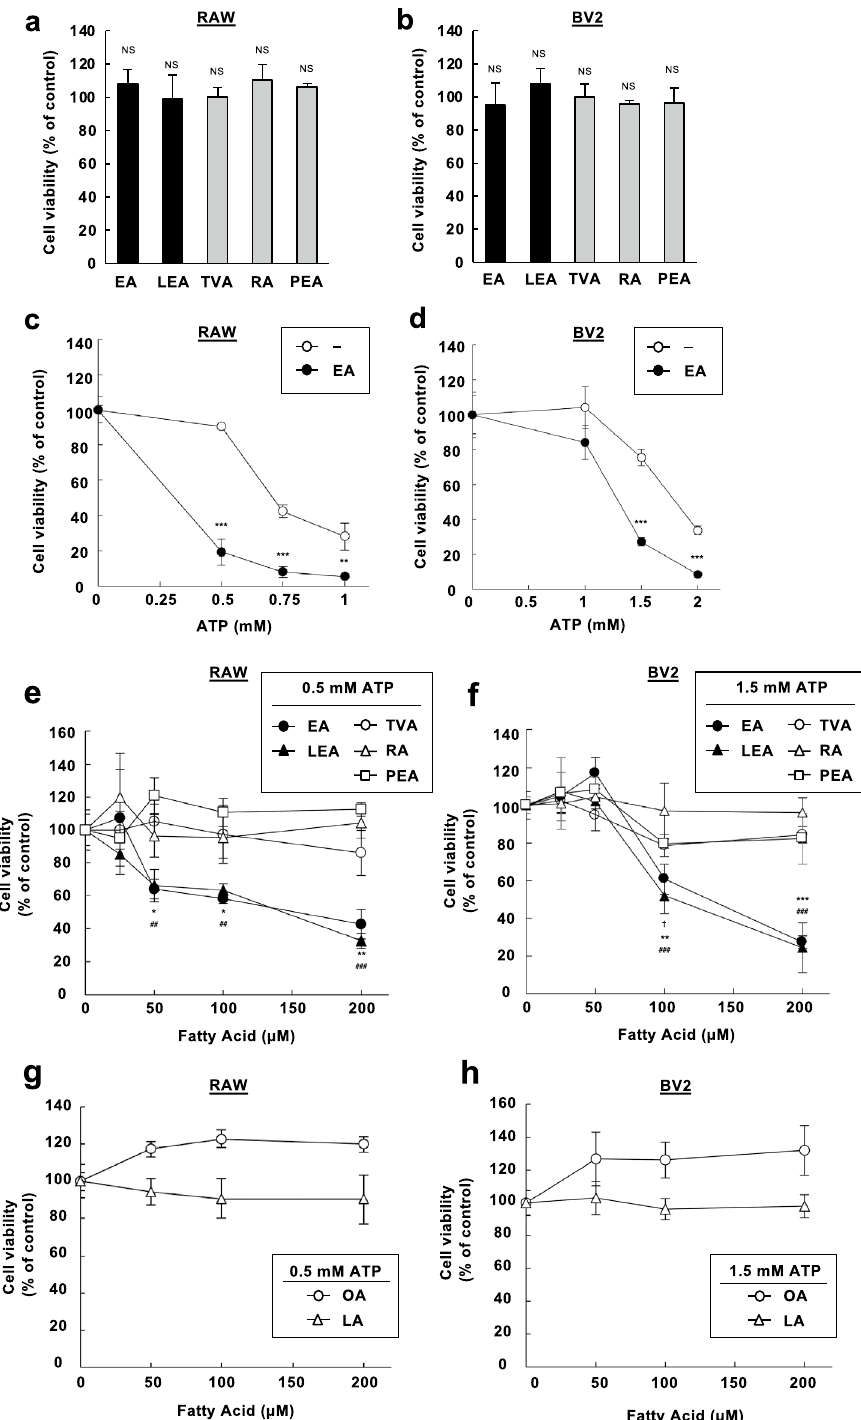
Figure 2. iTFAs specifically promote eATP-induced apoptosis. ( a , b ) RAW264.7 ( a ) and BV2 ( b ) cells were treated with the indicated TFAs for 20 h at 200 µM, and assayed for cell viability. Data are shown as mean ± SD (n = 3). NS: not significant (vs control without fatty acid). ( c , d ) RAW264.7 ( c ) and BV2 ( d ) cells were pretreated with 200 µM EA for 12 h, stimulated with various concentrations of ATP for 6 h, and assayed for cell viability. Data are shown as relative cell viability (mean ± SD, n = 3), normalized with the viability of cells stimulated with ATP without fatty acid. **p < 0.01; ***p < 0.001 (vs ATP-stimulated cells without EA). ( e – h ) RAW264.7 ( e , g ) and BV2 ( f , h ) cells were pretreated with the indicated concentrations of TFAs ( e , f ) or CFAs ( g , h ) for 12 h, treated with ATP at 0.5 mM (e, g) and 1.5 mM ( f , h ) for 6 h, and then assayed for cell viability. Data are shown as relative cell viability (mean ± SD, n = 3), normalized with the viability of cells stimulated with ATP without fatty acid. EA: *p < 0.05; **p < 0.01; ***p < 0.001. LEA: ## p < 0.01; ### p < 0.001. TVA: † p < 0.05 (vs ATP-stimulated cells without fatty